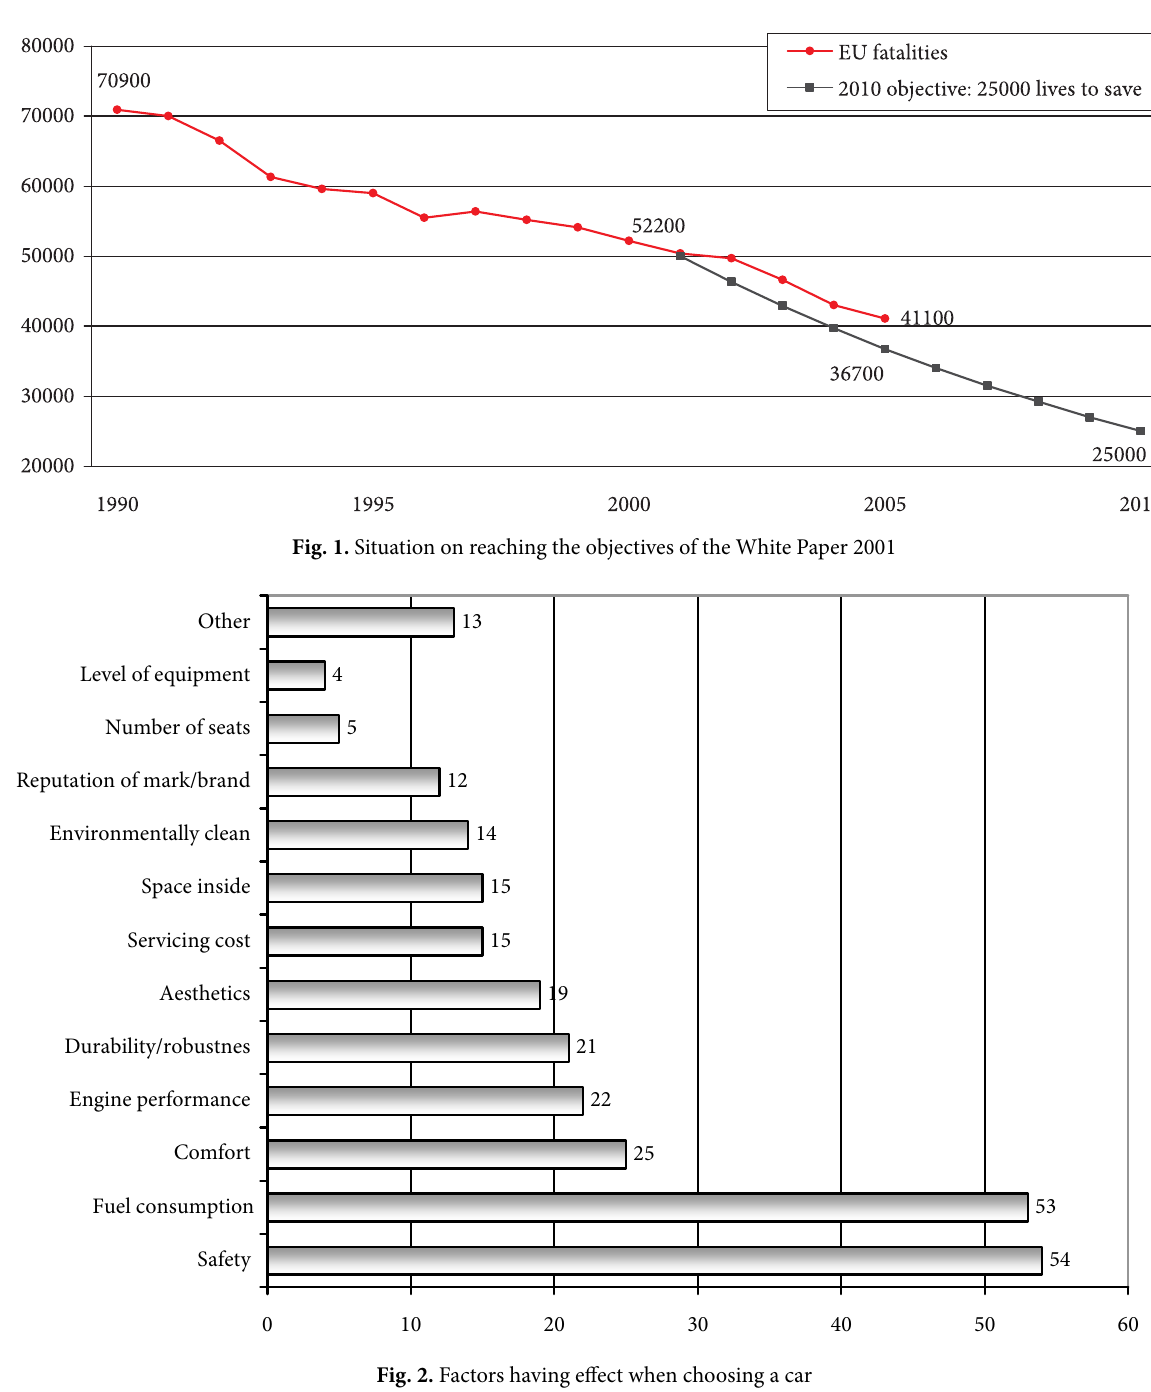
Fig. 2. Factors having eff ect when choosing a